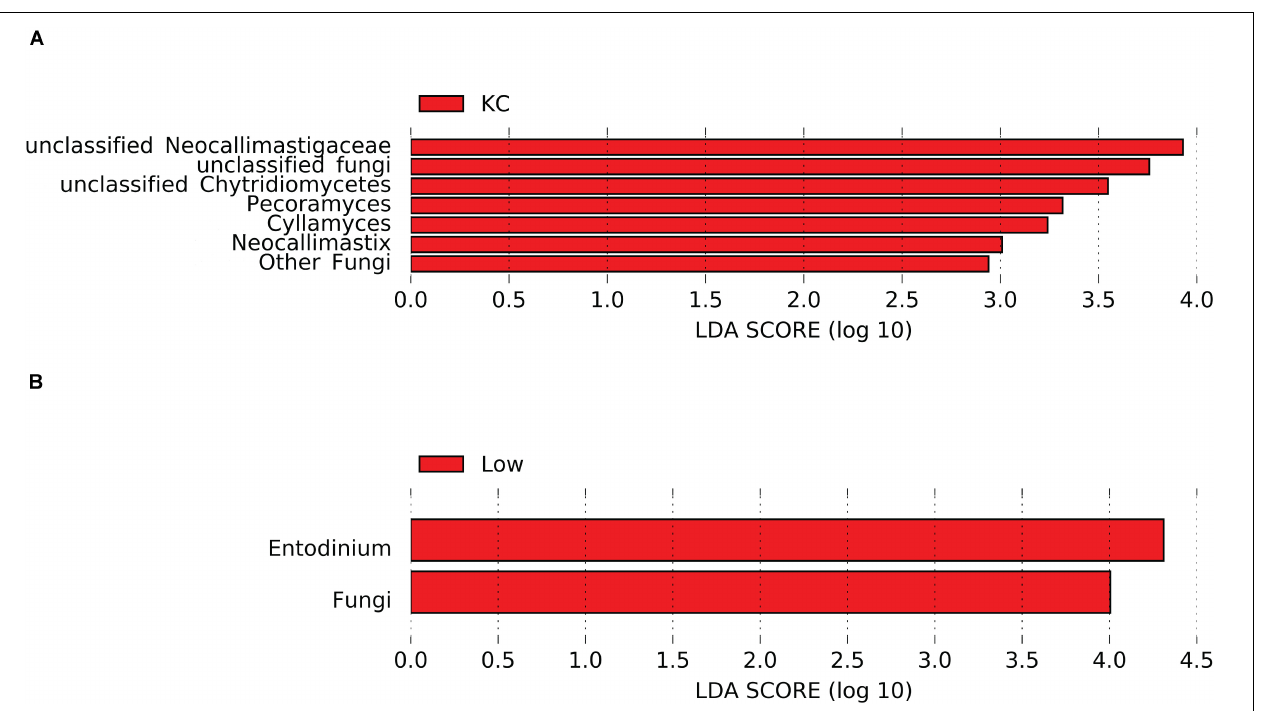
FIGURE 5 | Differential rumen eukaryotic features between the three beef cattle breeds (A) and high- and low-residual feed intake (RFI) steers (B) by linear discriminant analysis effect size (LEfSe). KC, Kinsella Composite beef steers; Low, steers with low